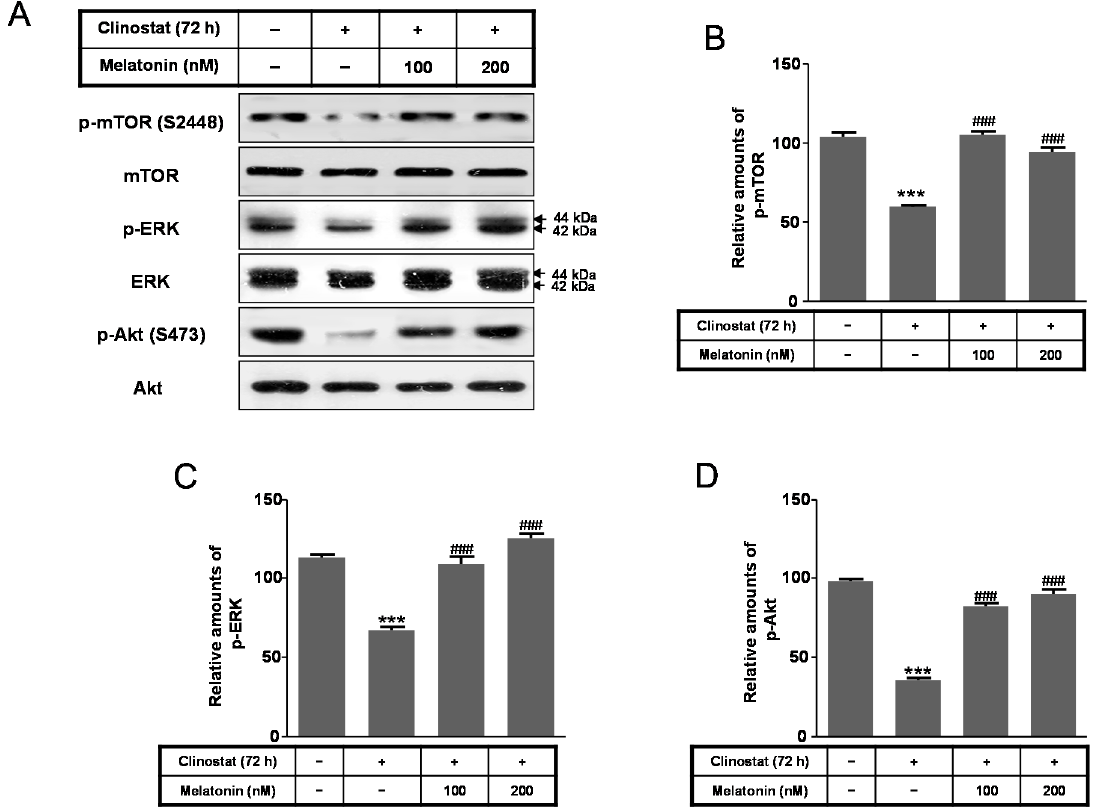
Figure 3. Phosphorylation of mTOR, ERK, and Akt with clinostat rotation and/or melatonin